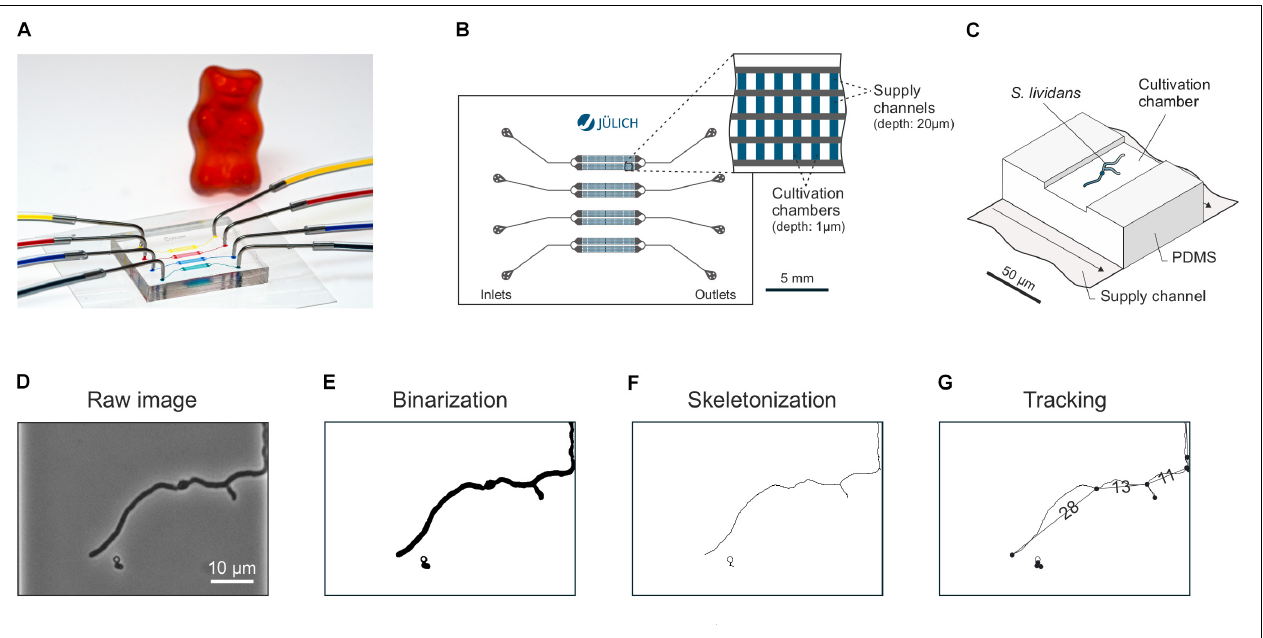
FIGURE 1 | Microfluidic single-cell cultivation (MSCC) and selected steps of the image based data analysis pipeline. (A) Photographic representation of the PDMS chip with connected in- and outlet tubing. Colorized liquids were used for demonstration purposes. (B) Schematic chip geometry. Four individual fluid lines with separate in- and outlets are arranged in 8 x 40 cultivation chamber arrays. (C) 3D illustration of the supply channels and a single cultivation chamber. (D–G) Major steps of the image processing pipeline: Raw images (D) were binarized (E) before being converted into skeletons (F) which could be subsequently analyzed by spatiotemporal tracking (G) in terms of total branching length and mycelial sections (Sachs et al., 2018 (in